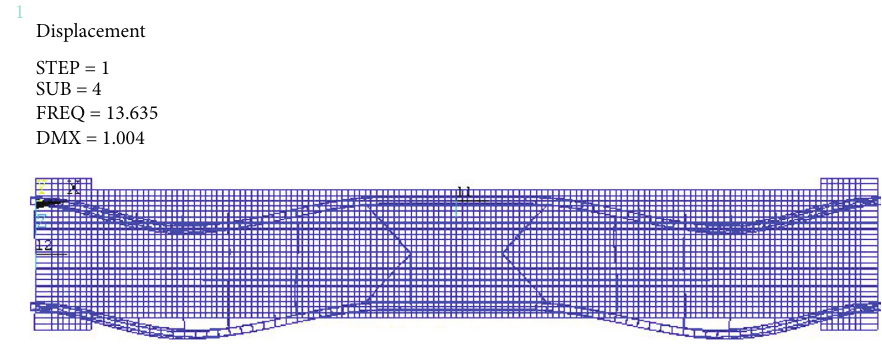
Figure 19: The fourth order buckling mode of arch bridge under case 1.